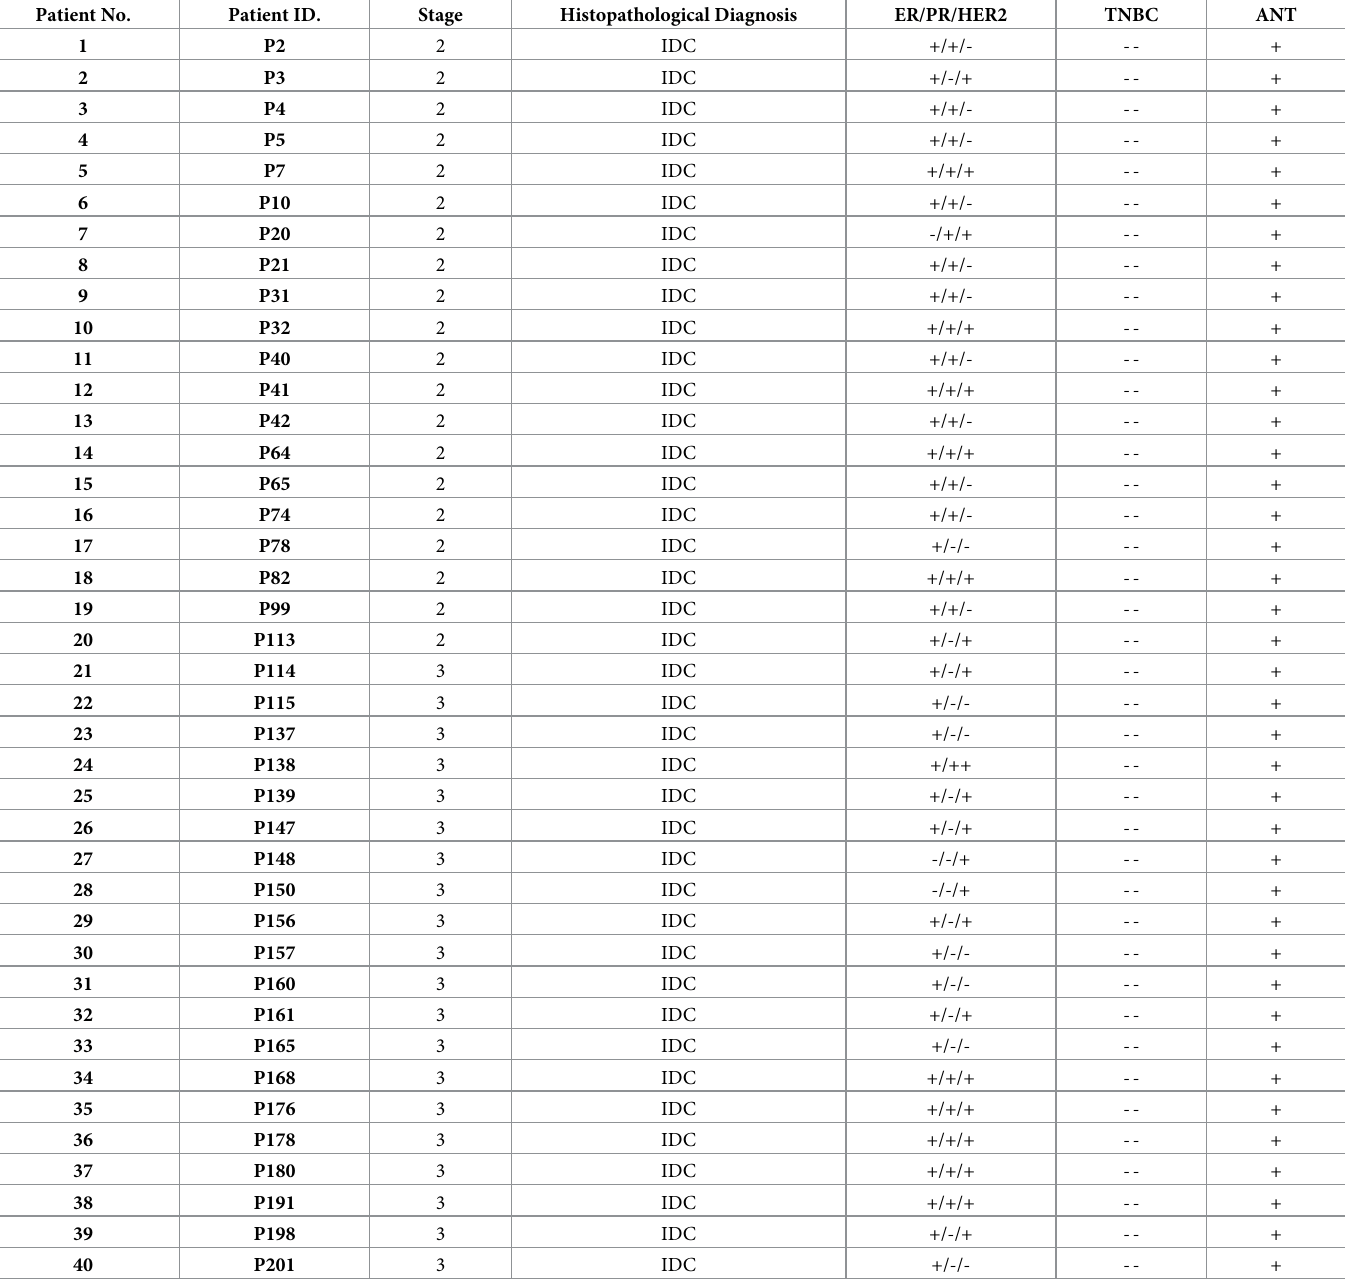
Table 1. Clinical pathological characteristics and molecular sub-type of stage 2 and stage 3 of breast cancer patients. Patient No. Patient